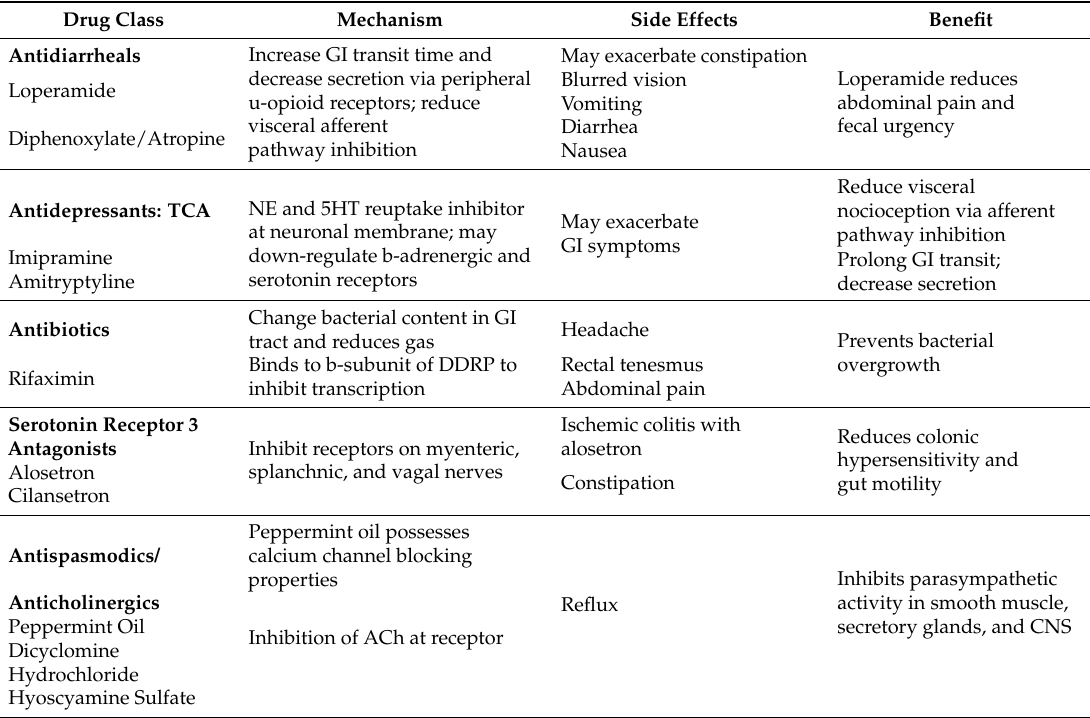
Figure 1. Treatment options for IBS based on symptoms. Treatment options for IBS are based on the symptoms such as constipation, diarrhea and mixed presentation of constipation and diarrhea. Table 2. General pharmaceutical treatment options for